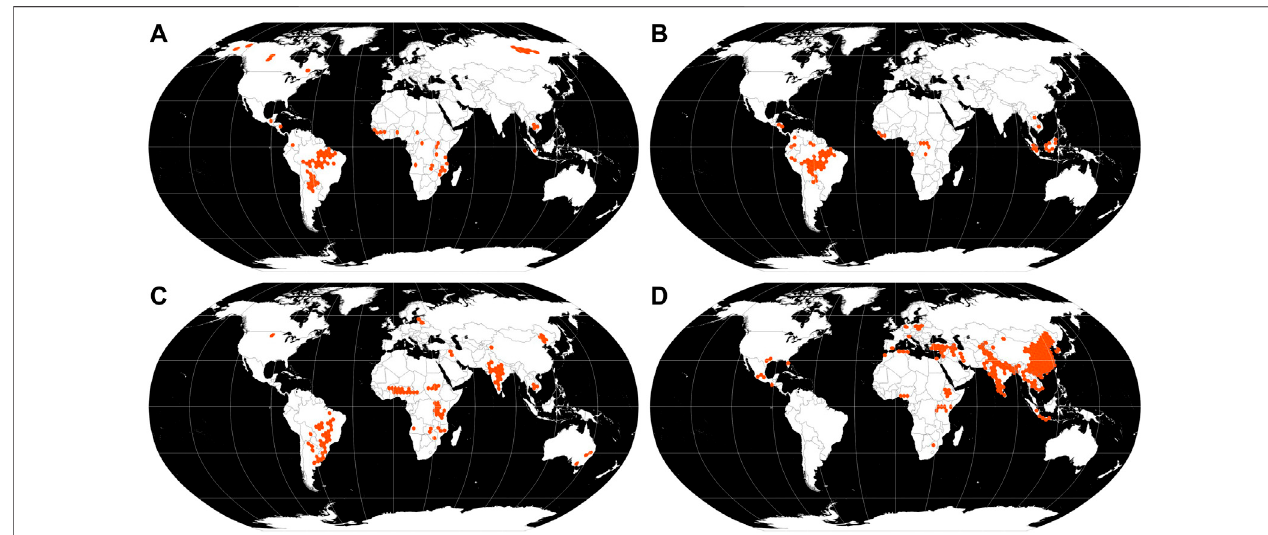
FIGURE 12 | Global 2000 – 2020 LCLUC hotspots de fi ned as the ISEA3H GDGGS hexagon grid cells (70,000 km 2 in area) that include 50% of the respective thematic quantity of the global total. (A) Deforestation. (B) Forest AGC reduction. (C) Cropland expansion. (D) Built-up area expansion.